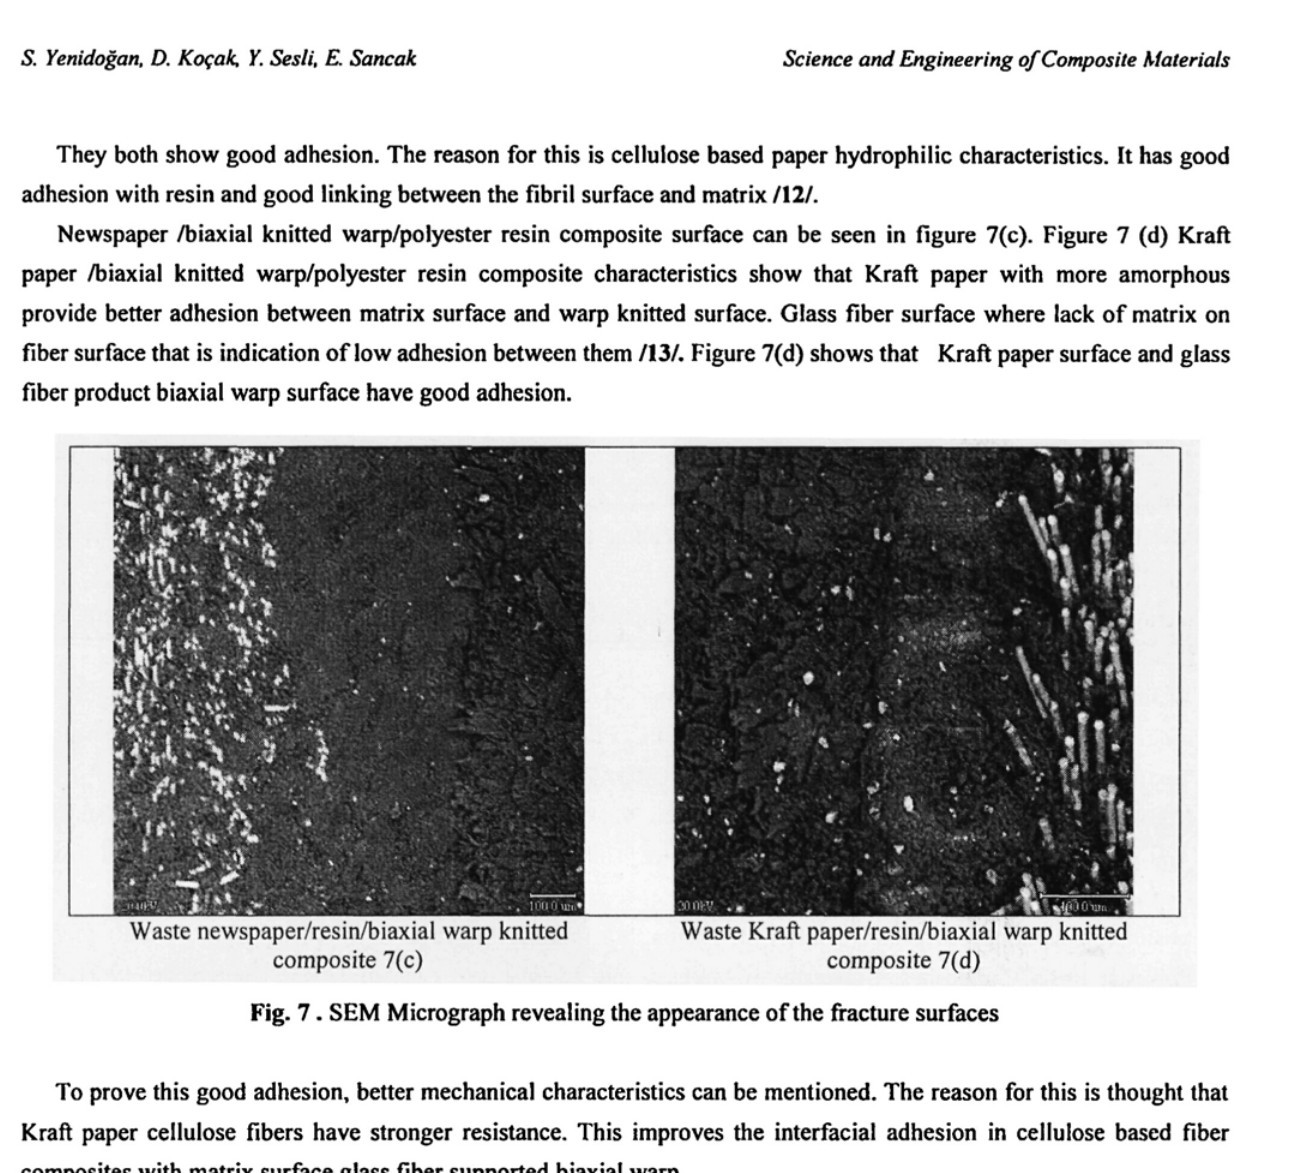
Fig. 7. SEM Micrograph revealing the appearance of the fracture